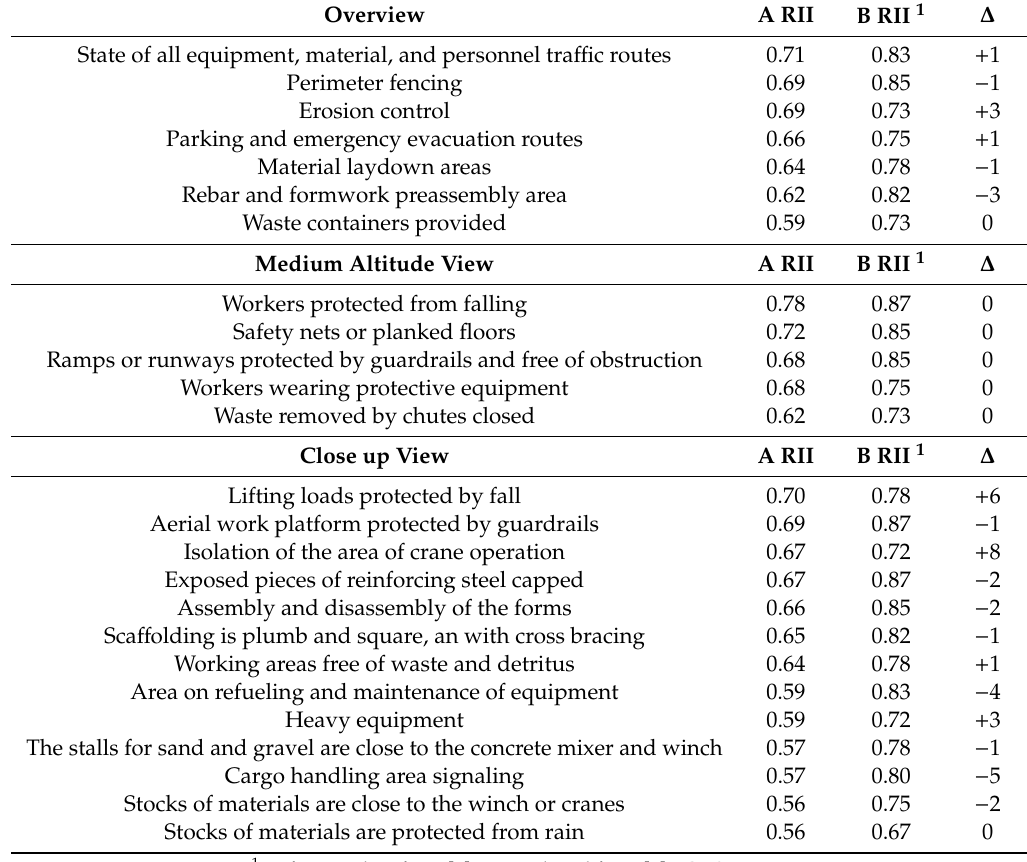
Table 5. Relative importance index for UAV safety inspection tasks based on acquisition